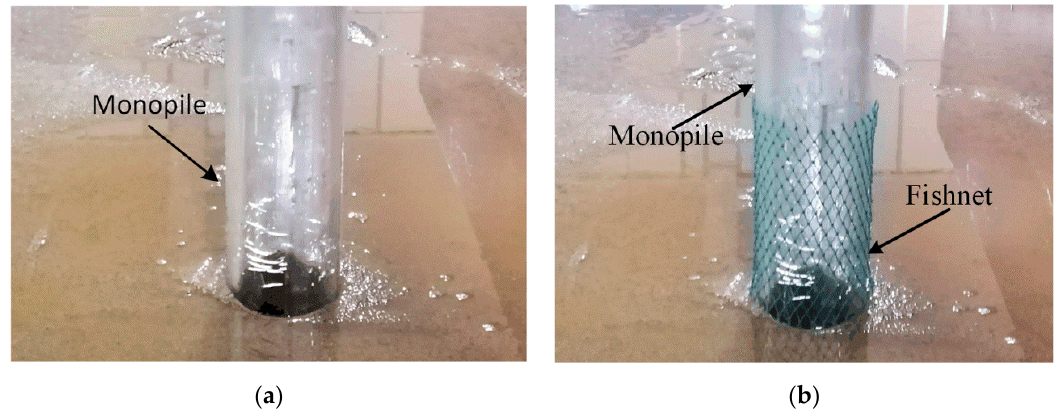
Figure 2. “Fishnet” technology: ( a ) before using the fishnet; ( b ) after using the fishnet.